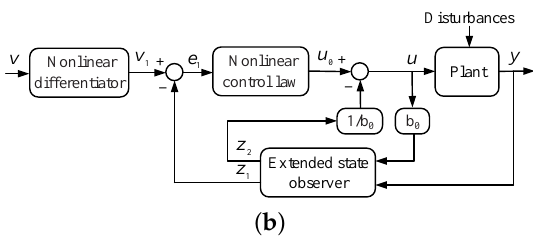
Figure 4. Block diagram of ( a ) the proposed sensorless DTC strategy; ( b )